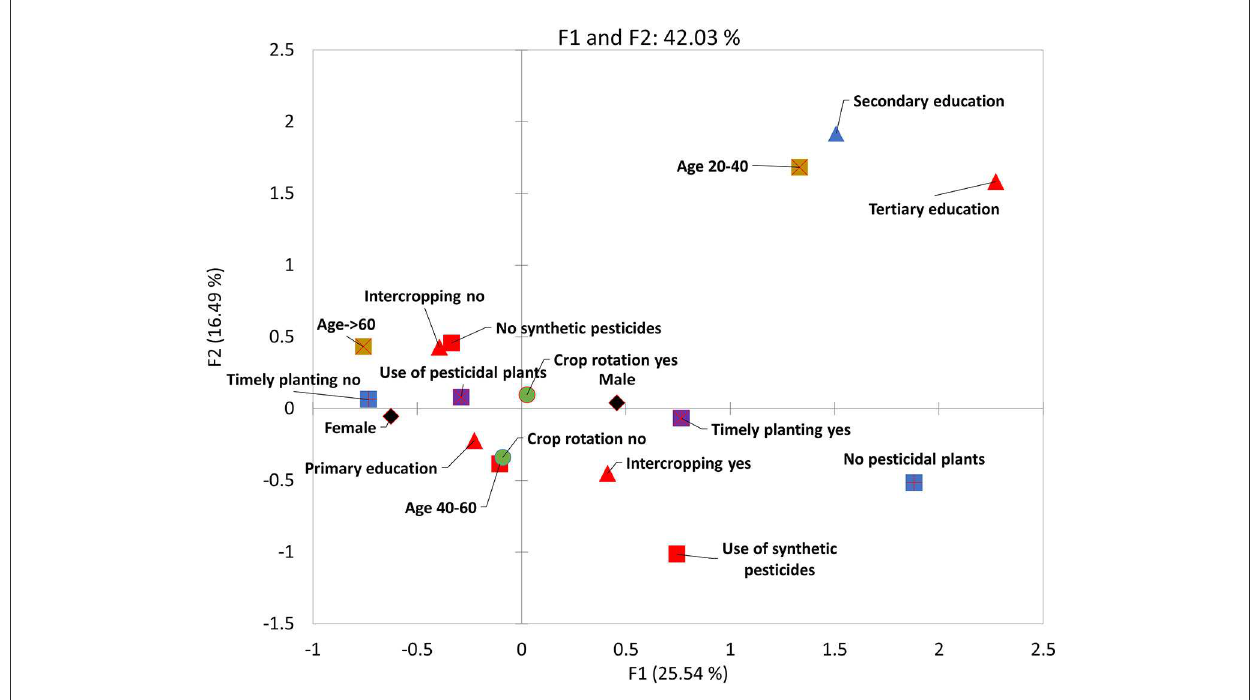
FIGURE3 Multiple correspondence analysis showing relationships between key demographic information of respondents and their practices related to soil-borne insect pests and disease management practices, in Narumu Ward, Kilimanjaro Region, Tanzania.